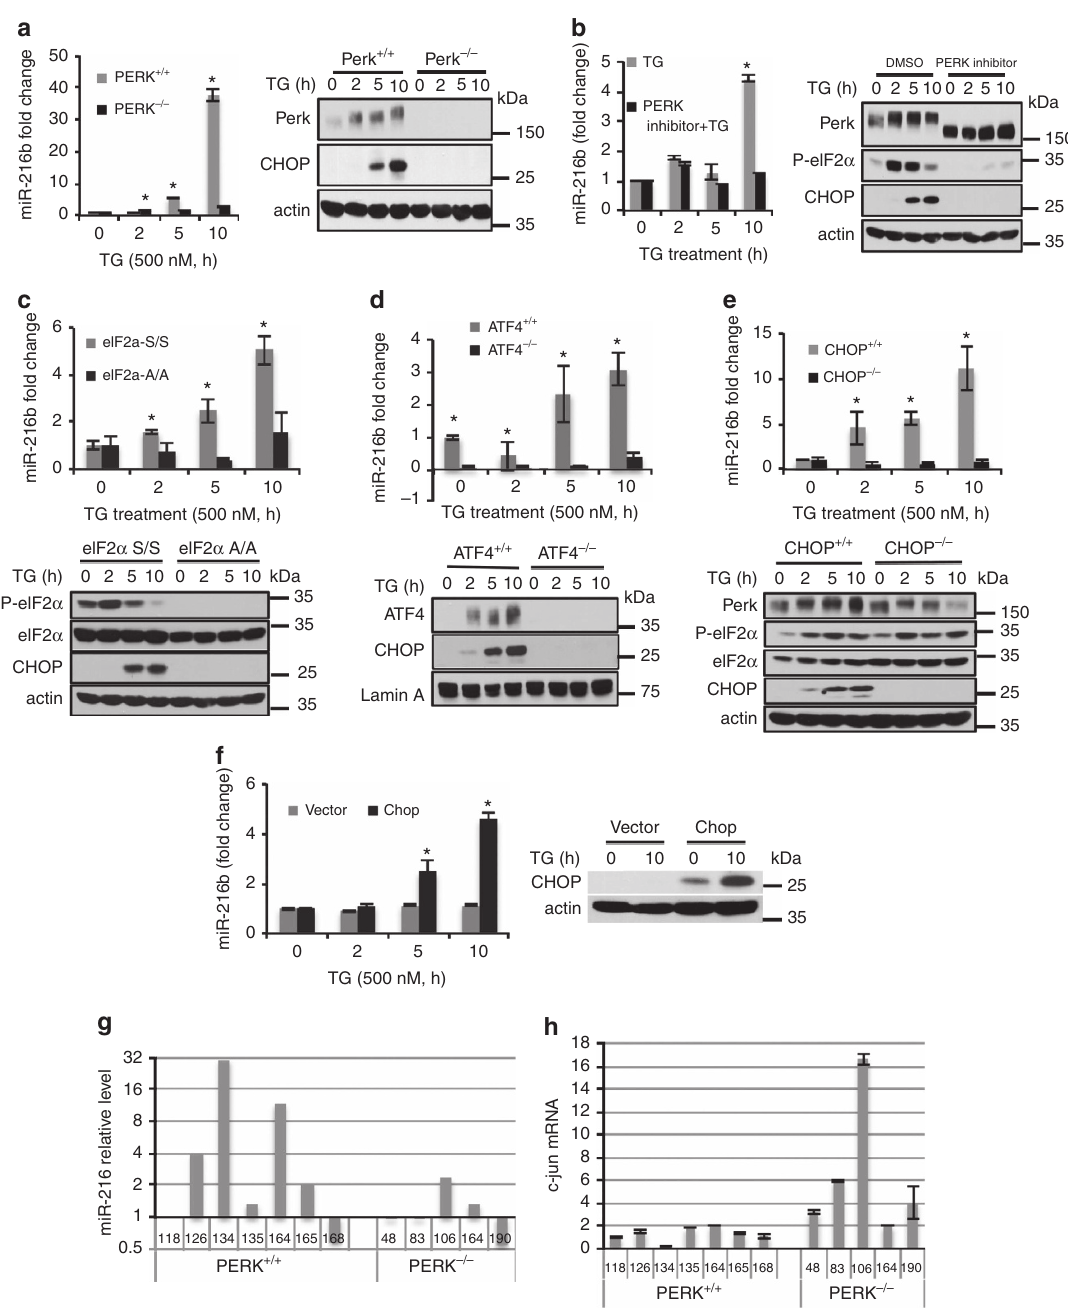
Figure 2 | PERK-dependent miR-216b induction. ( a ) PERK þ / þ and PERK (cid:2) / (cid:2) MEFs were treated with 500nM TG for indicated times. MiR-216b was assessed by qPCR (left graph); PERK and CHOP were assessed by immunoblot (right). ( b ) MiR-216b levels were quantified by qPCR following exposure of cells to thapsigargin and a small-molecule PERK inhibitor (left). PERK, eIF2 a -p and CHOP induction were assessed by immunoblot (right). ( c – e ) MEFs of the indicated genotype were treated with TG (500nM) for indicated intervals. Protein extracts from these cells were immunoblotted for the proteins as indicated (lower panels) and miR-216b levels were quantified by qPCR (upper panels; n ¼ 3). ( f ) CHOP (cid:2) / (cid:2) MEFs were transfected with vector or CHOP and 2 days later treated with TG (500nM) for indicated intervals. Protein extracts from these cells were immunoblotted for CHOP and miR-216b levels quantified by qPCR ( n ¼ 3). ( g ) MiR-216b expression and ( h ) c-Jun mRNA levels were analysed in MMTV-Neu tumours from either PERK þ / þ or a PERK (cid:2) / (cid:2) background. Data represent mean ± s.d. of three independent observations. Statistical significance was analysed by Student’s t -test. (* P o 0.05, WT versus (cid:2) / (cid:2)